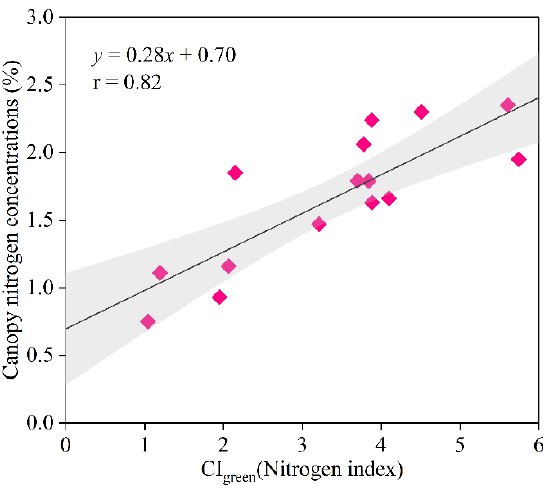
Figure 5. Relationship between CI green and canopy N concentrations (%). The grey area indicates the 95% confidence interval.